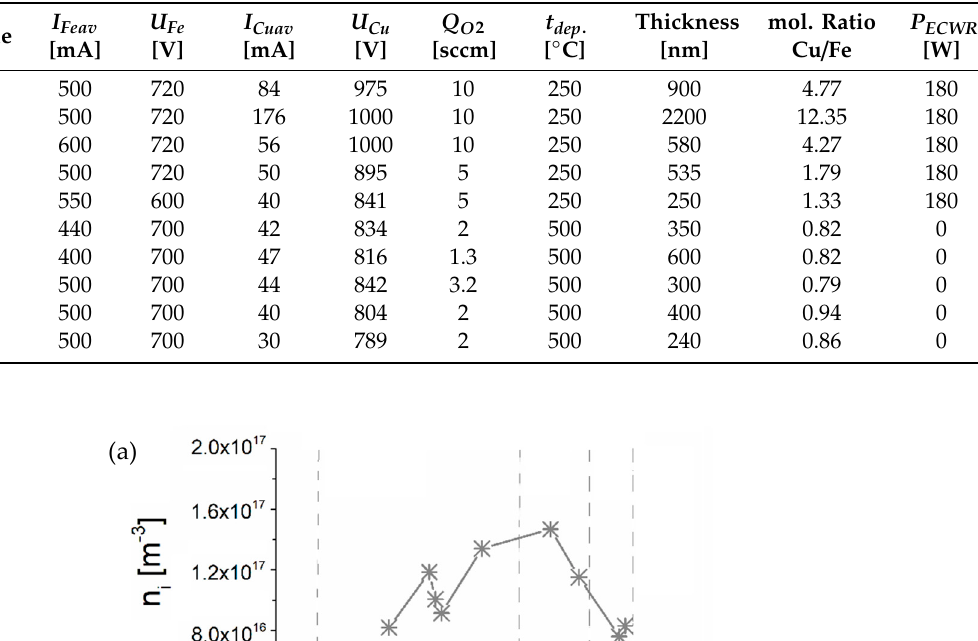
Table 1. List of films with significant deposition parameters.